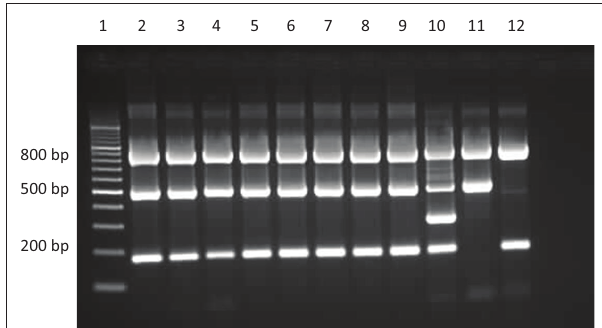
FIGURE 1: Brucella abortus species specific polymerase chain reaction products of samples collected from commercial and communal herds in KwaZulu-Natal in South